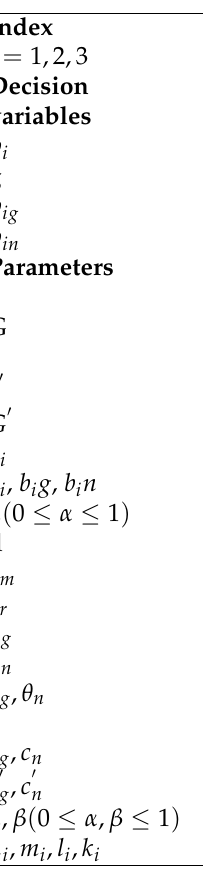
Table 2. Notation.